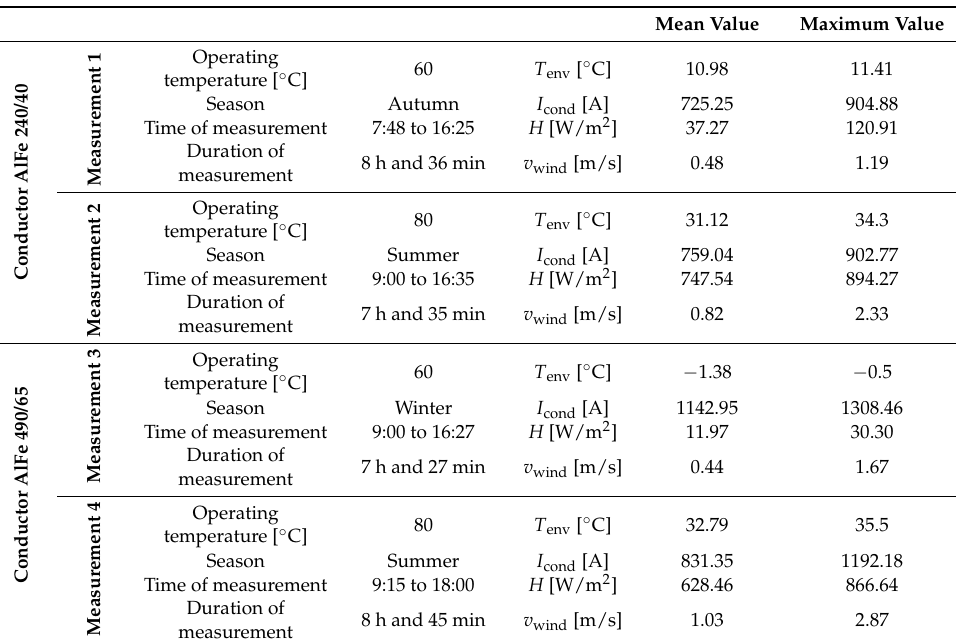
Table 8. Measurements